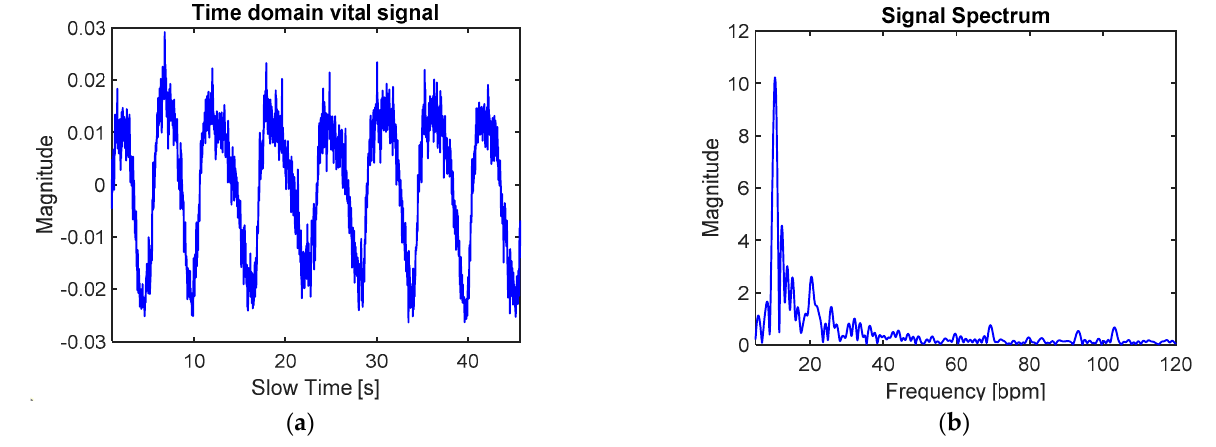
Figure 3. ( a) Time domain vital signal; ( b ) FFT of the vital signal. Figure 3. ( a ) Time domain vital signal; ( b ) FFT of the vital